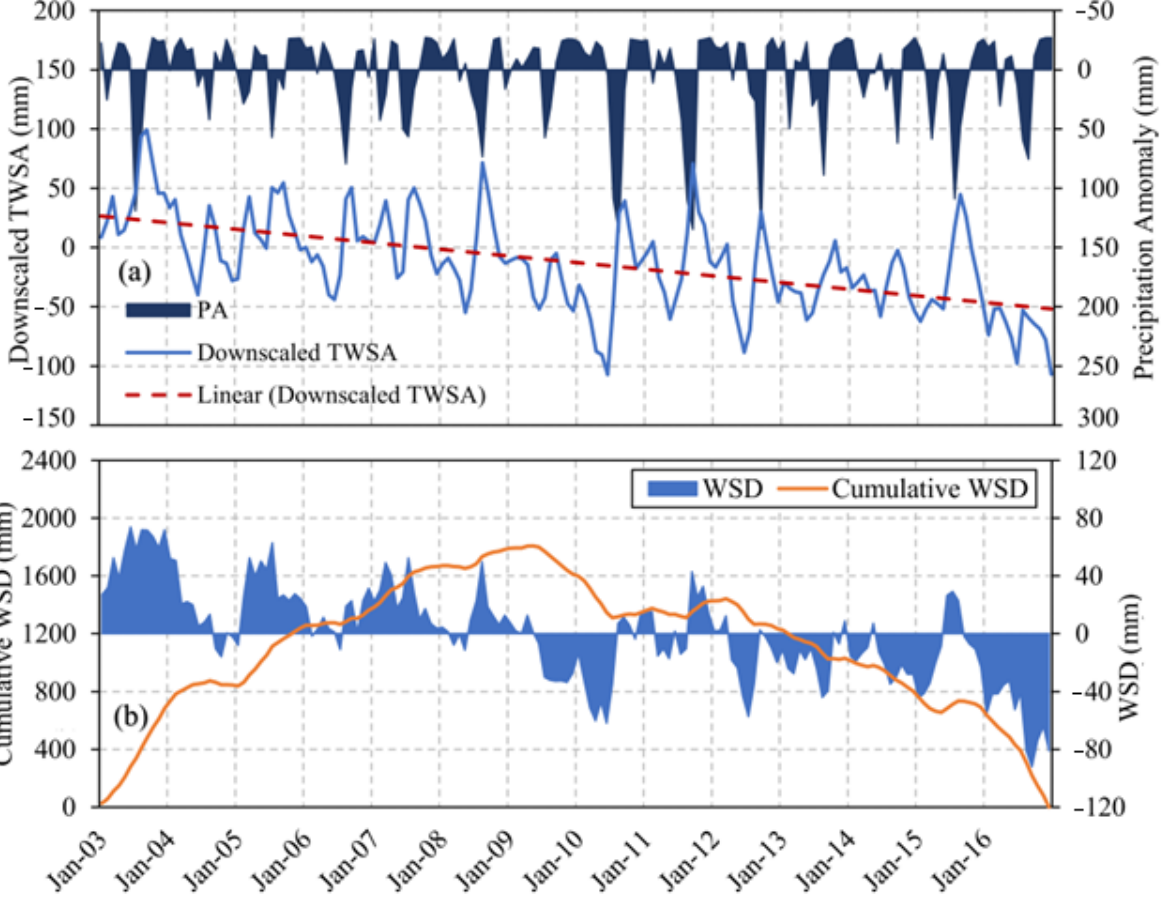
Figure 7. ( a ) Time series of downscaled TWSA and precipitation anomaly (PA) and ( b ) water storage deficit (WSD) and cumulative WSD for the IBIS.